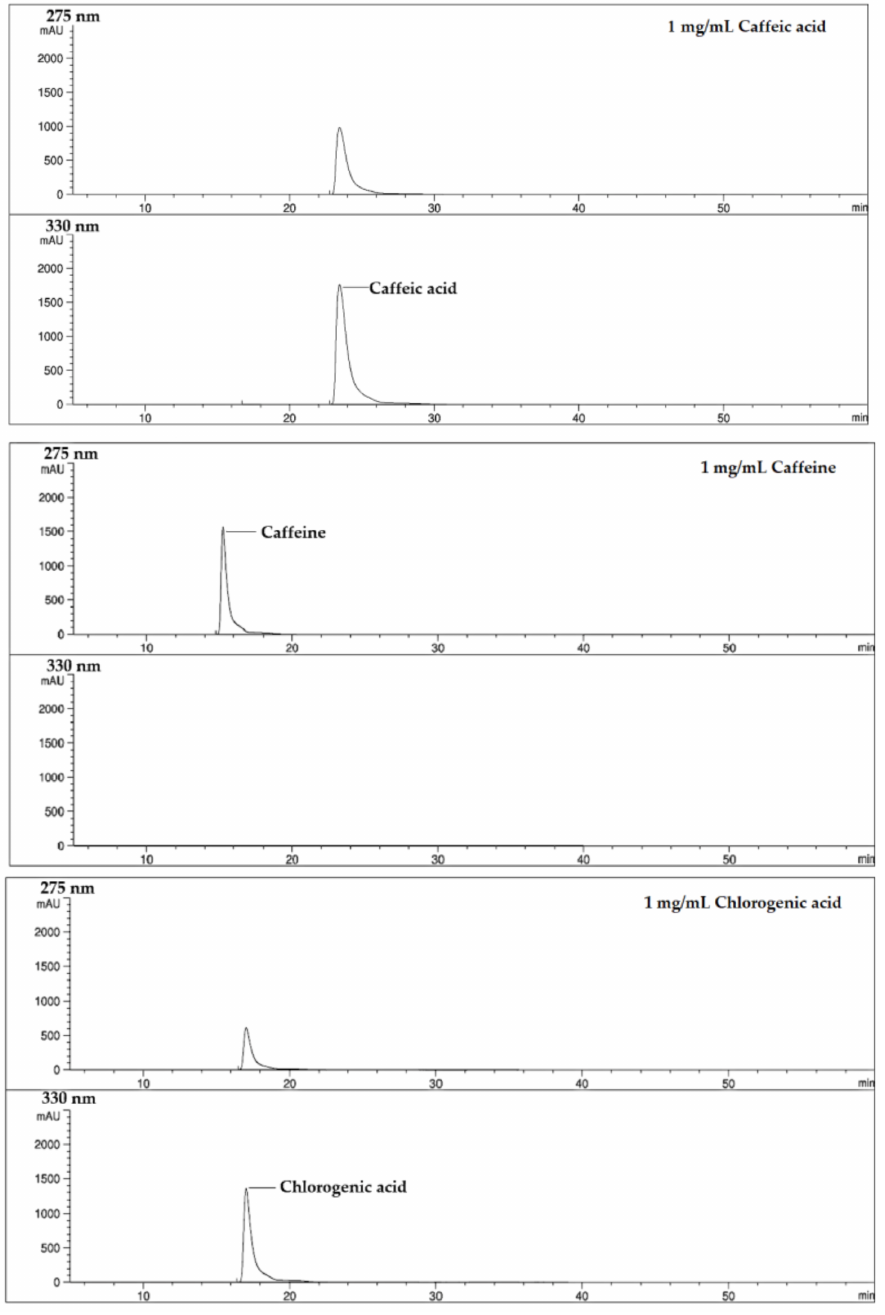
Figure 3. Chromatograms of coffee extracts, standard caffeic acid, caffeine and chlorogenic acid. Extracts of roasted coffee were prepared by the boiling, drip and espresso methods (( A – C ), respectively). The coffee extracts and authentic standards, including caffeic acid, caffeine and chlorogenic acid, were then subjected to HPLC-DAD analysis as has been described in Section